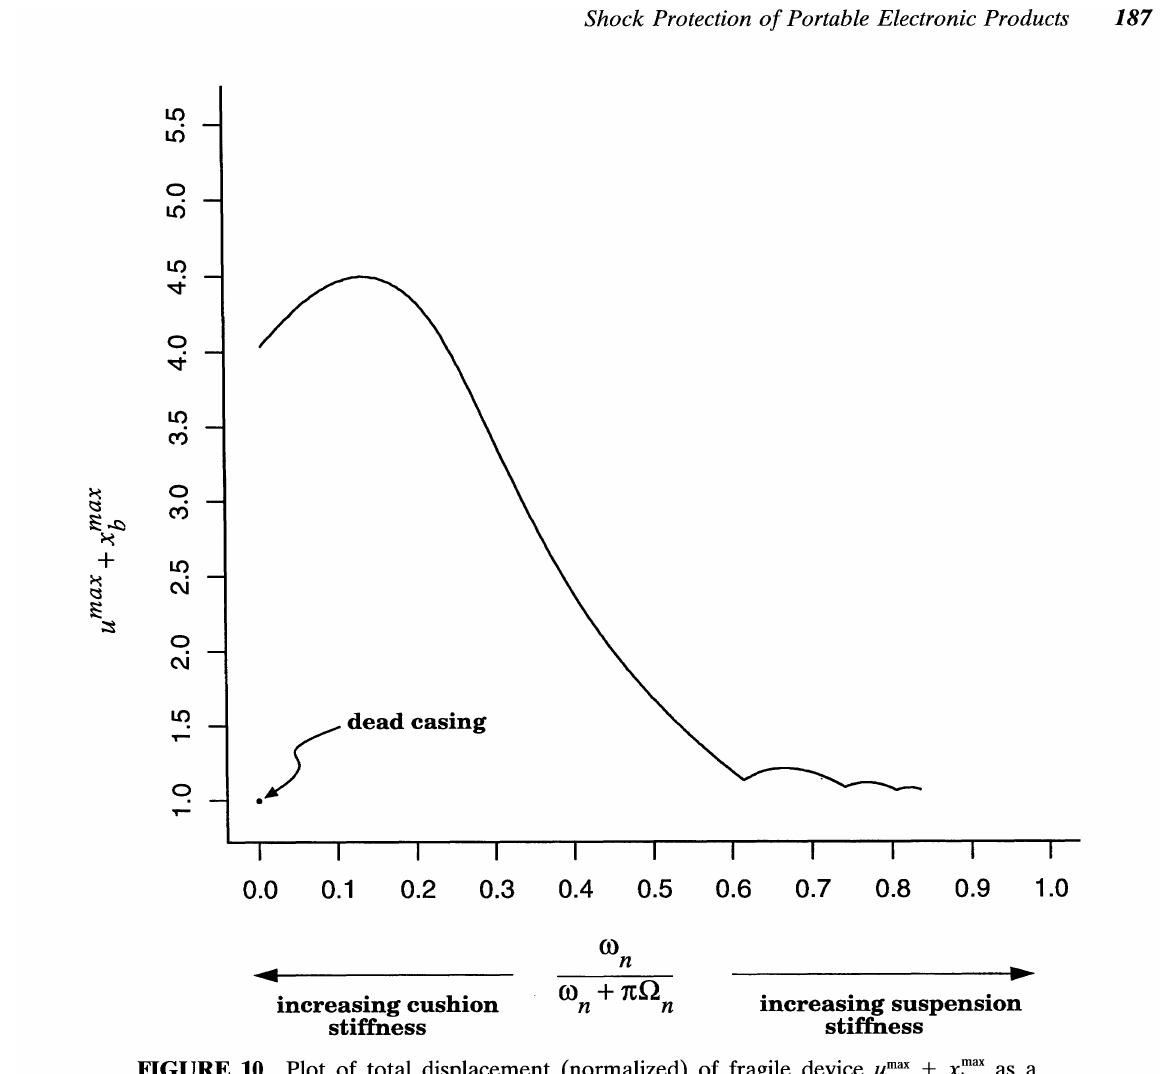
FIGURE 10 Plot of total displacement (normalized) of fragile device UDIaX + function of suspension and cushion stiffness ratio wn/(wn + ?Tn.) for the system of Fig.